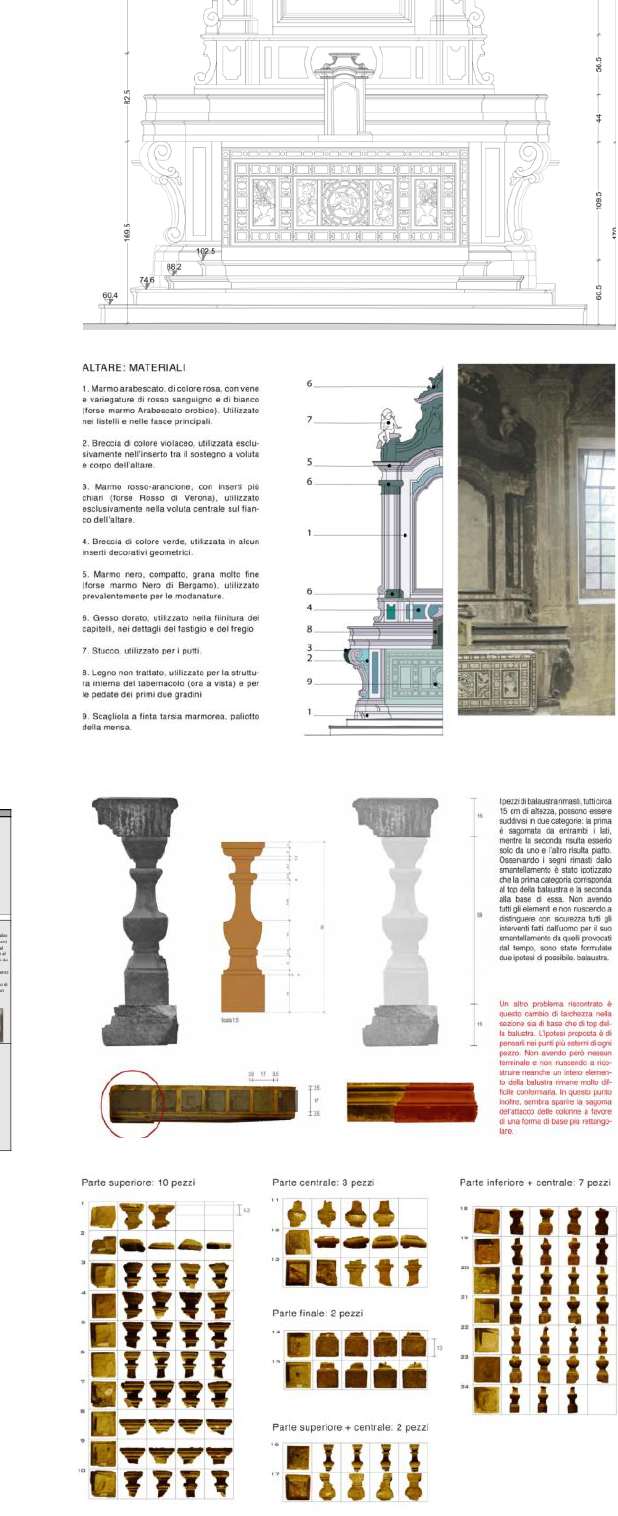
Figure 12. Images of Diurno di Porta Venezia. Figure 13. Images of the Church of San